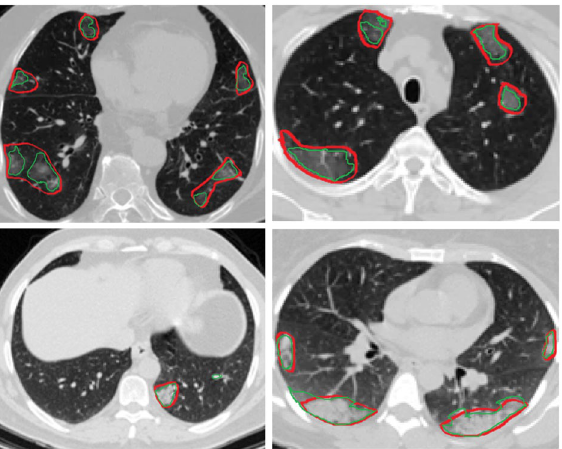
Figure 10. Qualitative evaluation of model performance on segmenting GGO (first row) and consolidation (second row) infection patterns. Ground truth and predicted infection regions have been indicated with red and green borders, respectively.